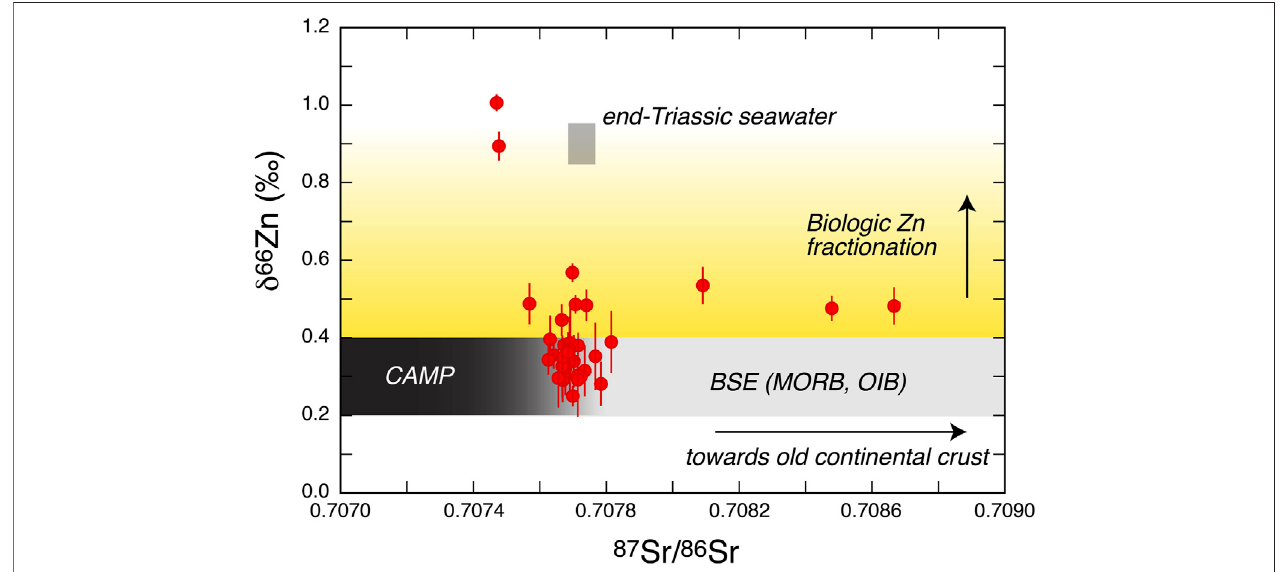
FIGURE7| CombinedgraphofSrandZnfortheMtSparagiosectionusedtoresolveseawatervsdetritaloriginsforelements.Theend-Triassic(201 – 201.5 Ma)Sr seawater composition is from McArthur et al. (2001).